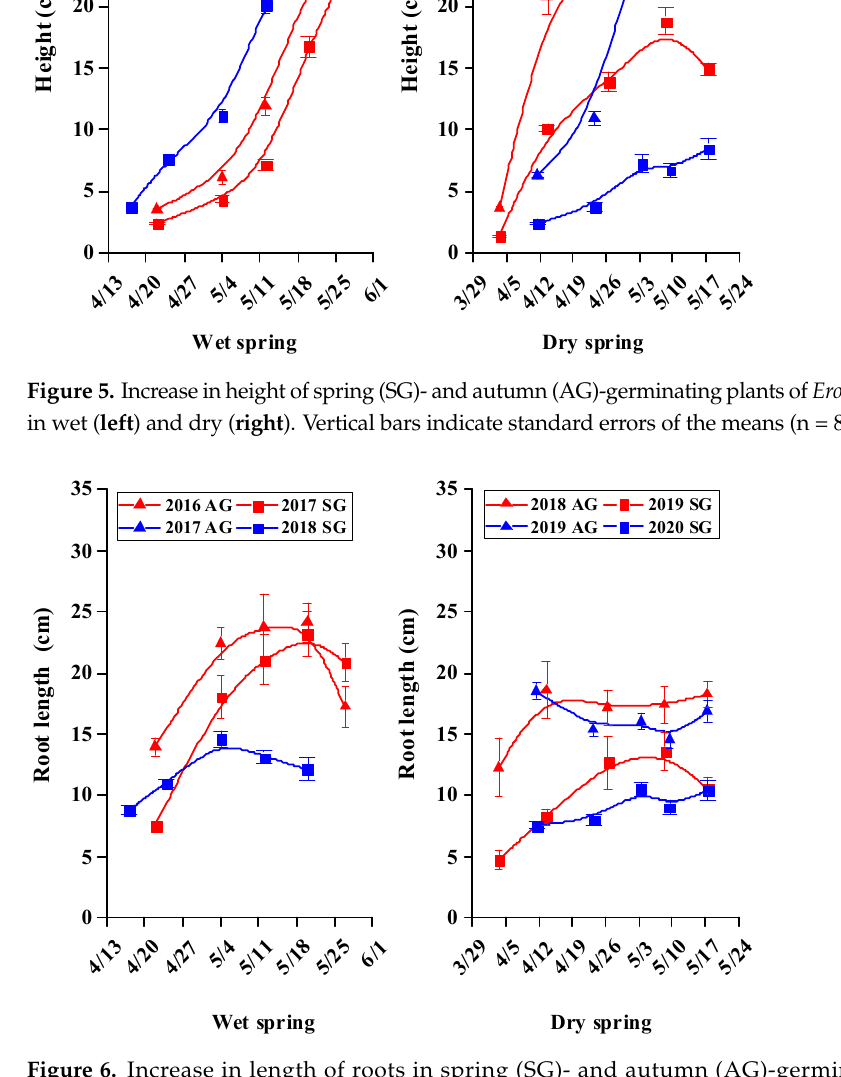
Figure 6. Increase in length of roots in spring (SG)- and autumn (AG)-germinating plants of Erodium oxyrhinchum in wet ( left ) and dry ( right ) springs. First three periods represent as vegetative stage, and last two periods represent as reproductive stage. Vertical bars indicate standard errors of the means (n = 8).